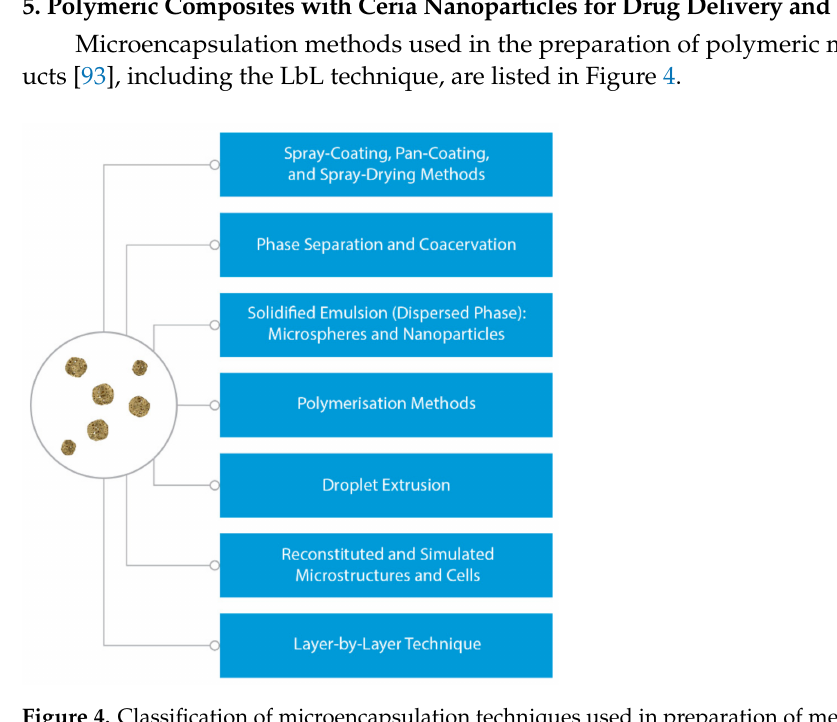
Figure 4. Classification of microencapsulation techniques used in preparation of medicinal